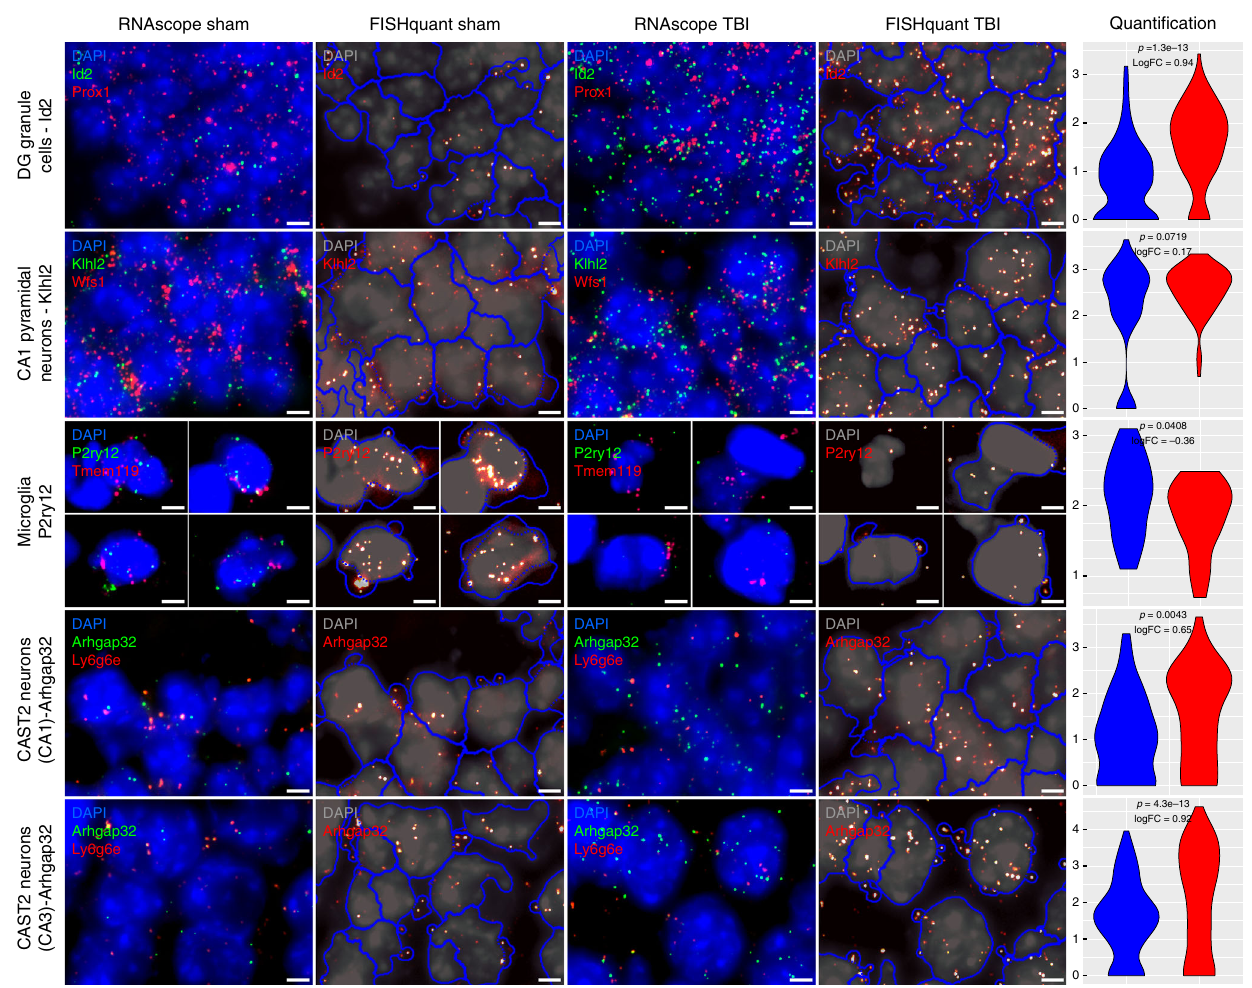
Fig. 7 Validation of select cell type speci fi c DEGs using RNAscope in situ hybridization. Representative fl uorescent microphotographs for Sham and TBI showing each DEG of interest (selected from Fig. 6a) along with cell marker genes with DAPI in the background. The RNAscope images for Sham ( fi rst column) and TBI (third column) display cell colocalization of each DEG (green) and the corresponding cell marker gene (red). The corresponding FISH- quant images for Sham (second column) and TBI (fourth column) show the automated cell segmentation (blue) overlayed on the 2D maximal projection of the DAPI z-stack images (gray) with the DEG of interest (green in the RNAscope images) indicated in bright dots. The quanti fi cation of the cell type speci fi c DEGs is shown in the violin plots (5th column) with Sham in blue and TBI in red. Only cells which meet a certain count threshold for the cell type marker gene are considered the appropriate cell type and used in the DEG quanti fi cation (details in Methods). The ln(counts per cell) of the DEGs are shown on the y -axis with the p -value from a bimodal likelihood ratio test and log fold change (logFC) between TBI and Sham samples indicated. These fi gures have been zoomed in 5x from the original form to show high magni fi cation detail of a few cells to more easily demonstrate colocalization of DEGs and cell markers. Lower magni fi cation photos which indicate the region which was magni fi ed are provided in Supplementary Fig. 11. Scale bars are 4 µ m. Sample size was n = 8